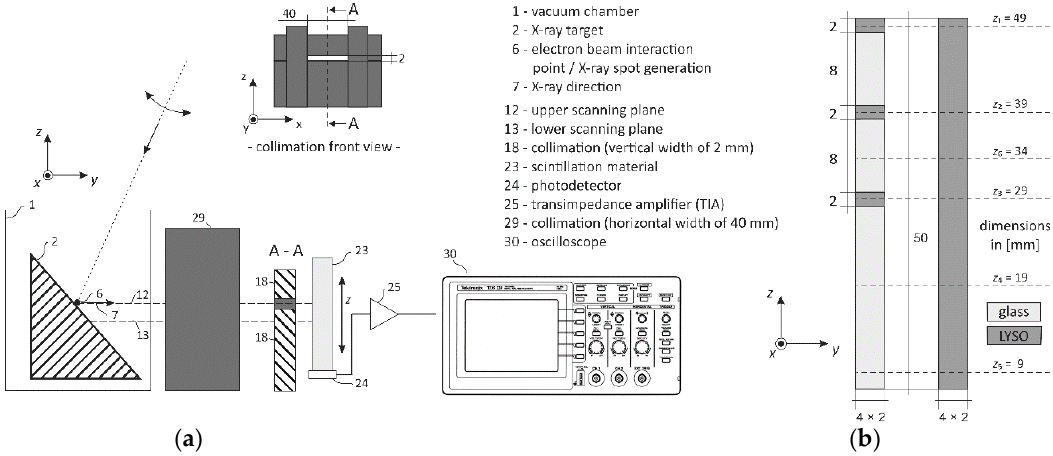
Figure 9. ( a ) Setup to investigate the principle of multi-plane scintillation detectors using ( b ) sandwich (left) and monolithic bar (right) detector design.